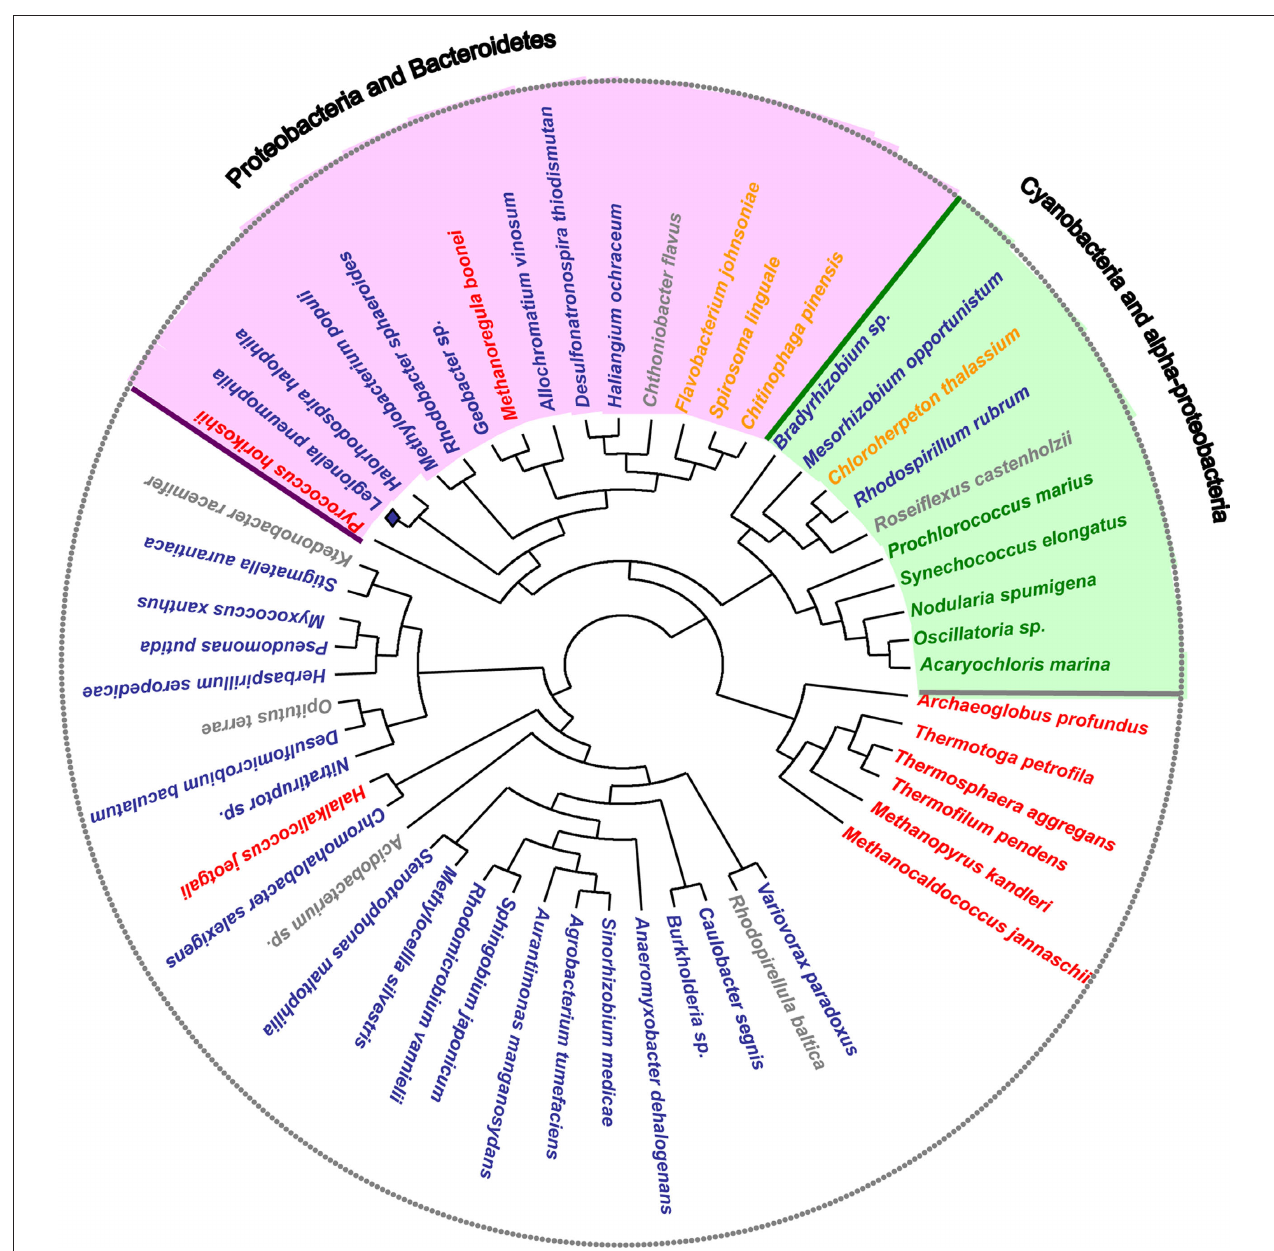
Figure 4 | Maximum likelihood unrooted KaiC amino acid sequence tree. Organisms containing both kaiB and kaiC systems are grouped in two main clades: Cyanobacteria and α -Proteobacteria (green), and Proteobacteria and Bacteroidetes (pink). In these groups some organisms that do not belong to the main phylogenetic group are present. This grouping indicates potential events of lateral gene